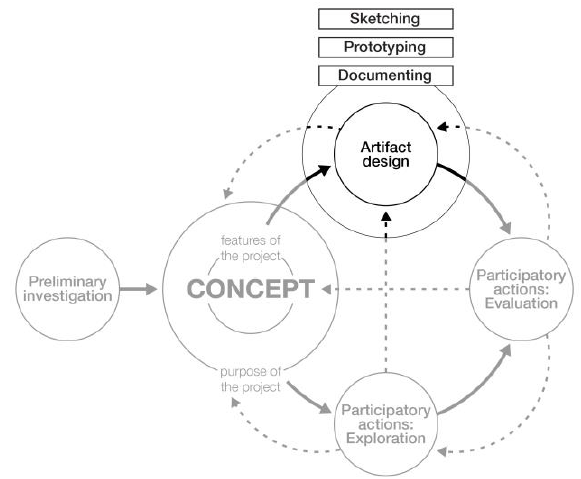
Figure 2 | Design process of the project with a focus on the design and development stage, discussed in this